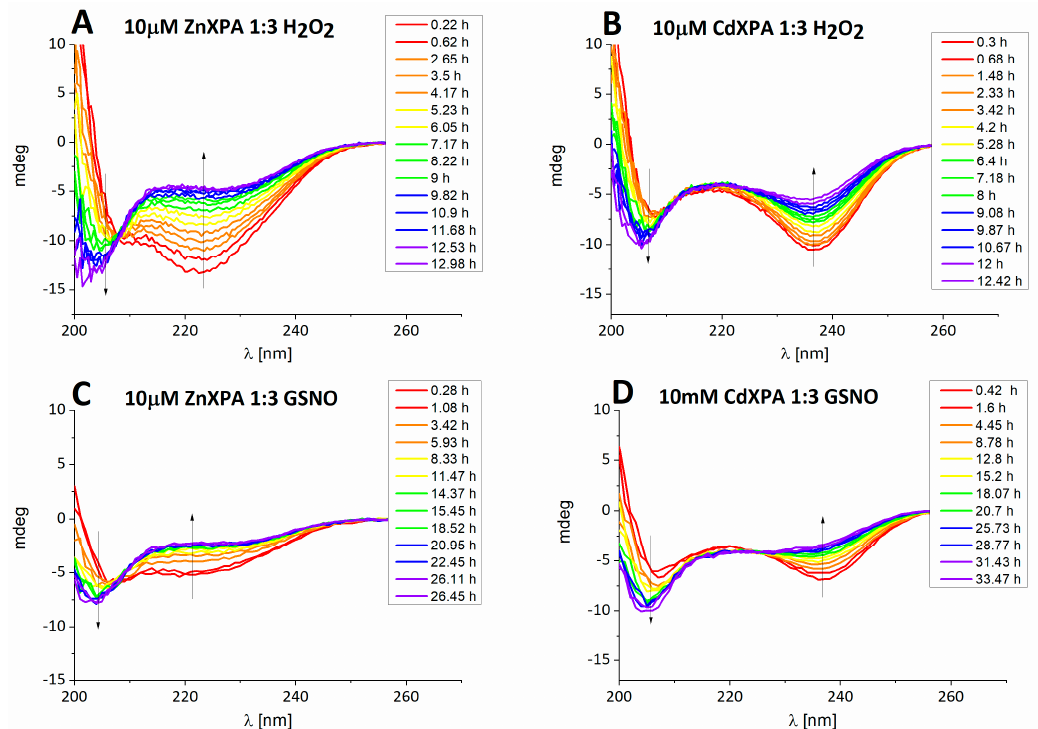
Figure 1. Examples of the time course of 10 μ M ZnXPAzf and CdXPAzf decomposition by